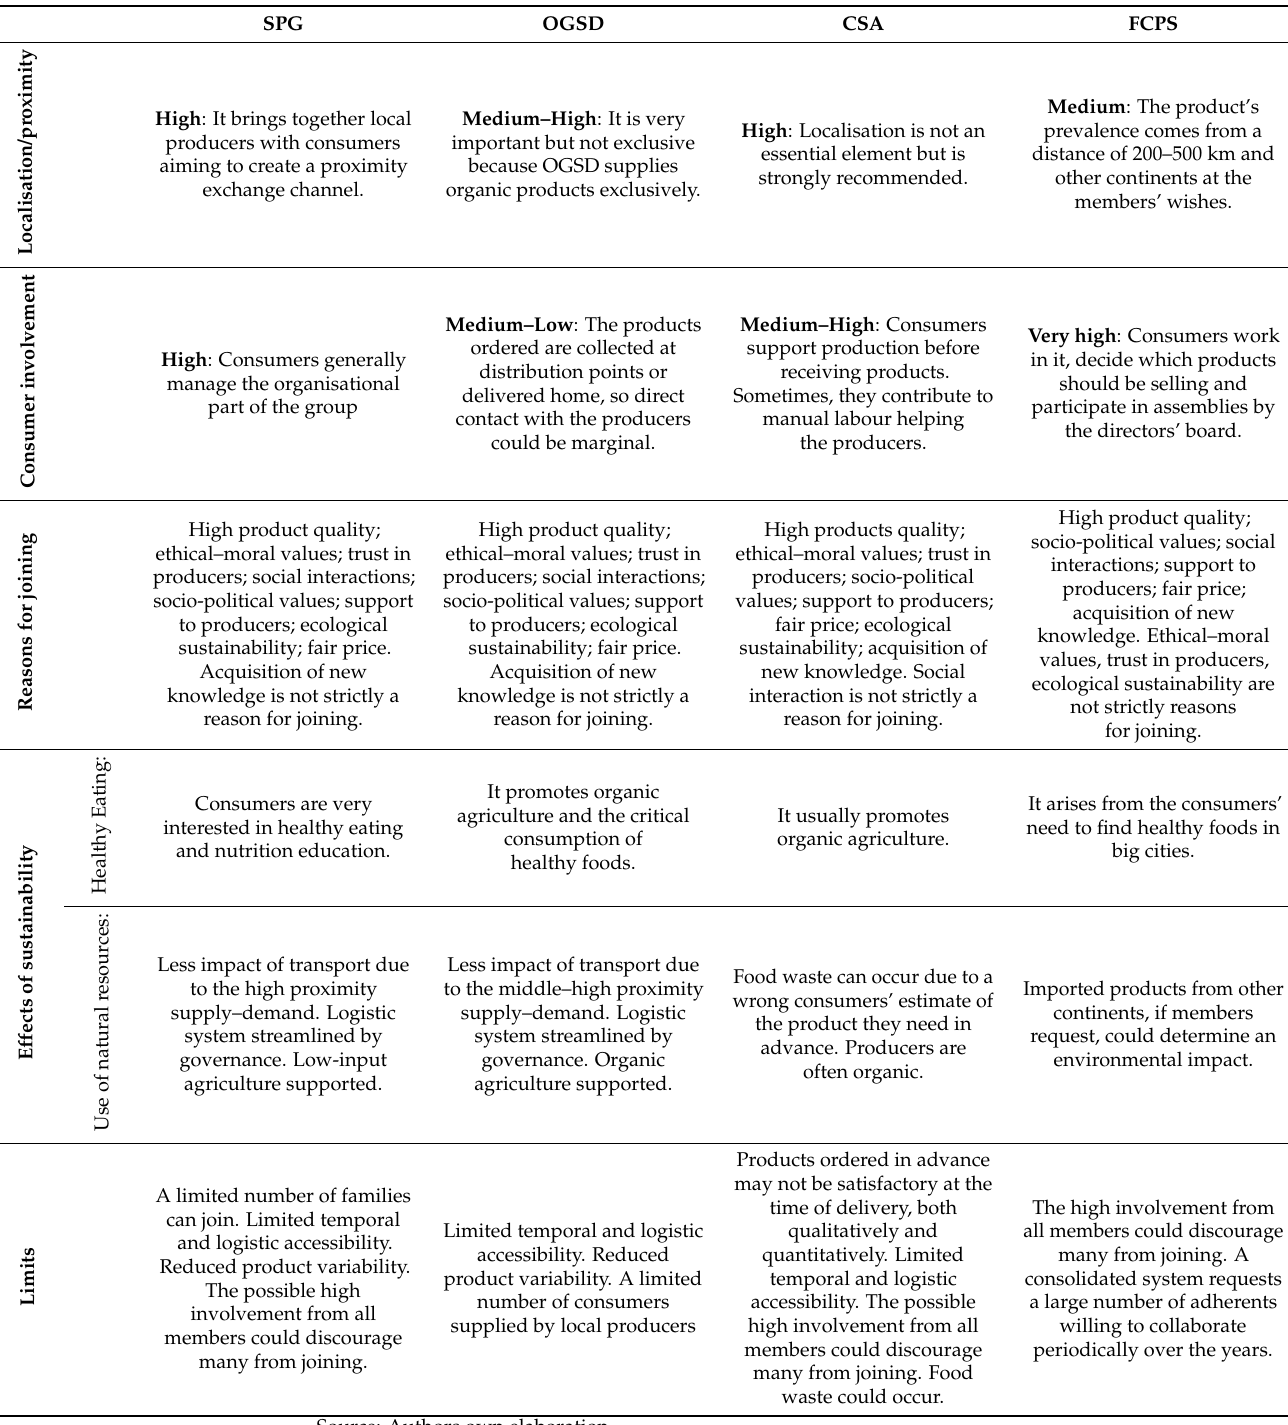
Table 1. Comparison between the